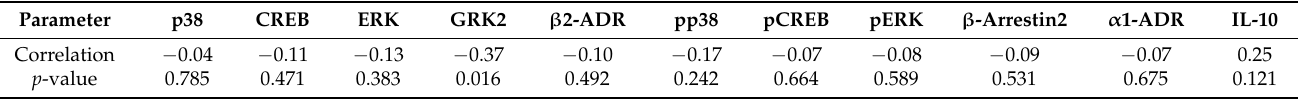
Table 3. Partial correlations of investigated parameters with duration of inflammation controlled for severity of